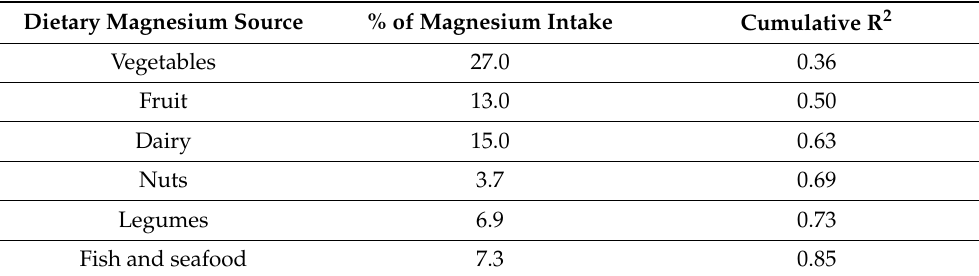
Table 1. Main sources of variability (cumulative R 2 ) and main sources (%) of dietary magnesium intake among participants in the SUN (“Seguimiento Universidad de Navarra”) cohort, 1999–2016. Dietary Magnesium